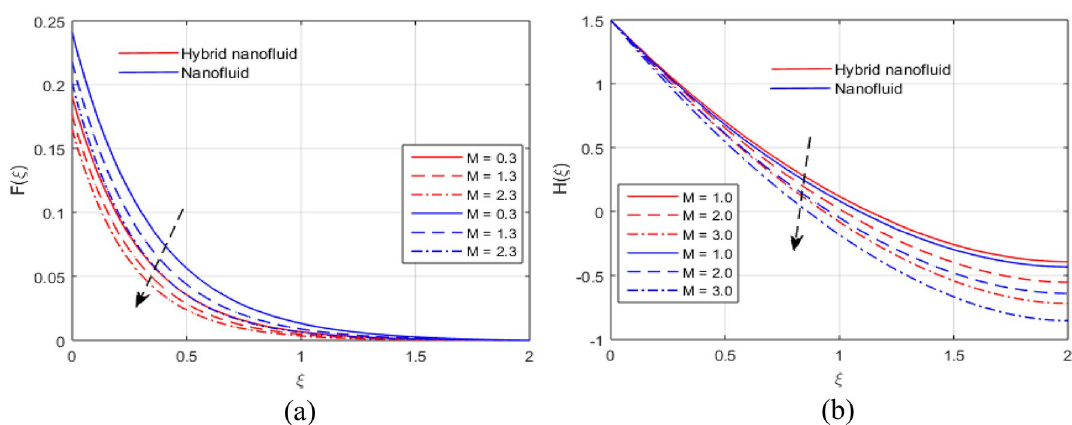
Figure 7. ( a , b ) Influence of M on F (ξ) and H (ξ)